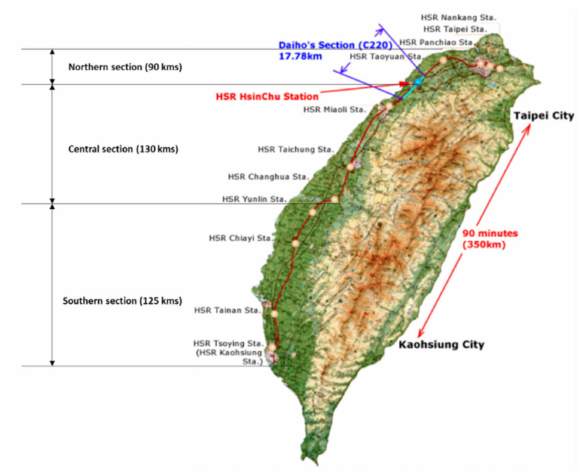
Figure 1. Stations of Taiwan’s high-speed rail (HSR) line [2].